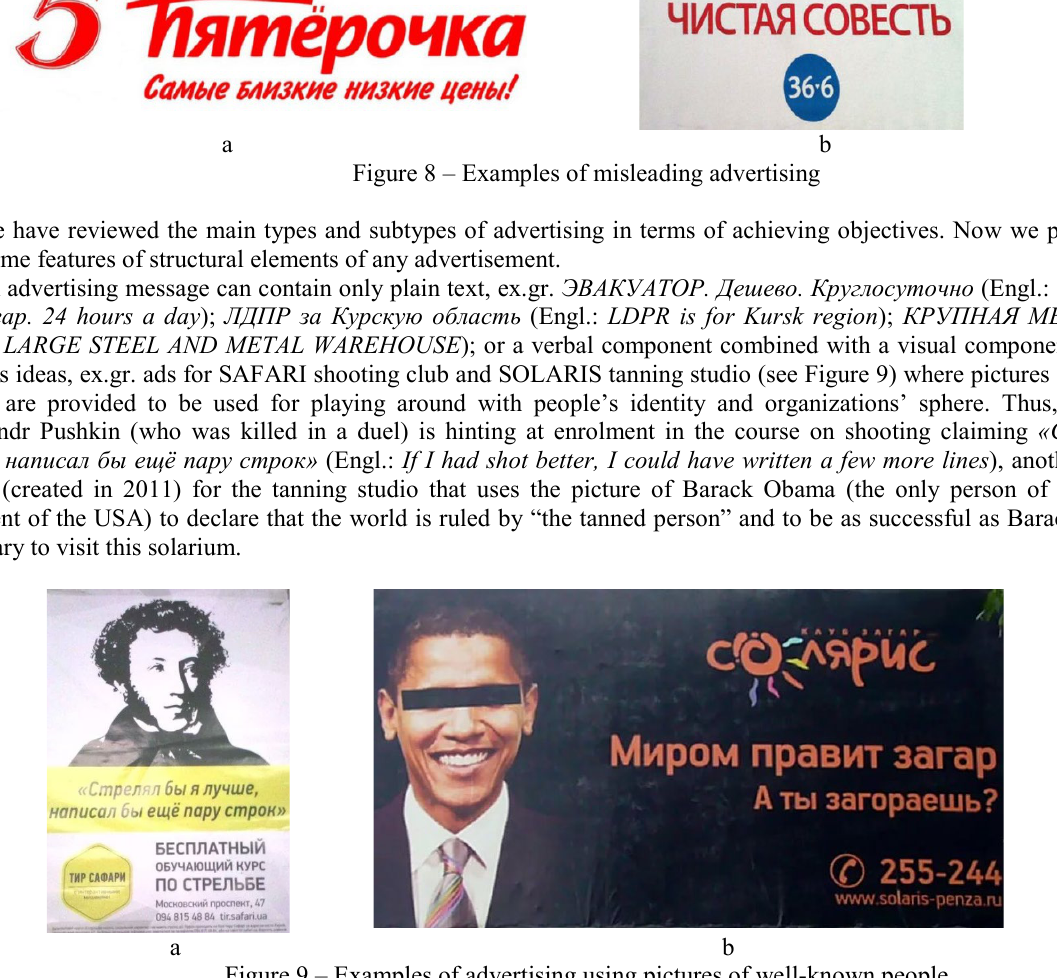
Figure 9 – Examples of advertising using pictures of well-known